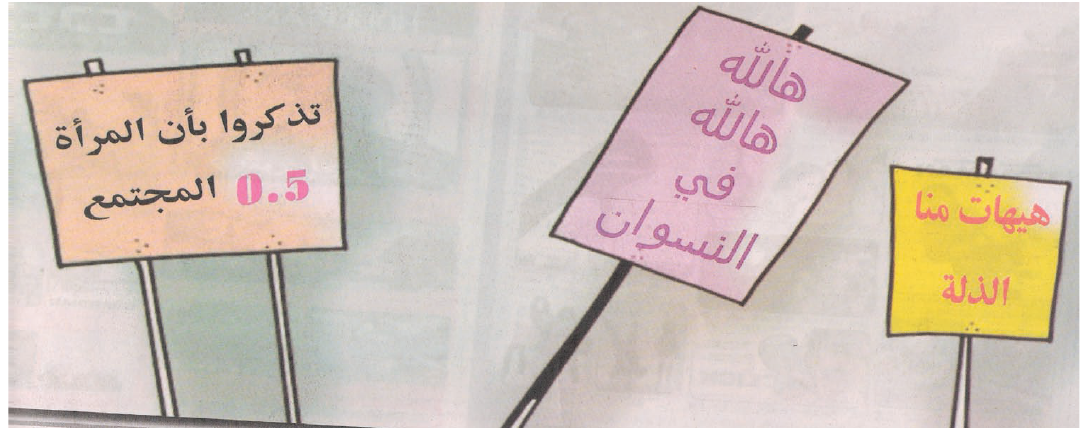
Figure 4: Neutral‐cynical cartoon